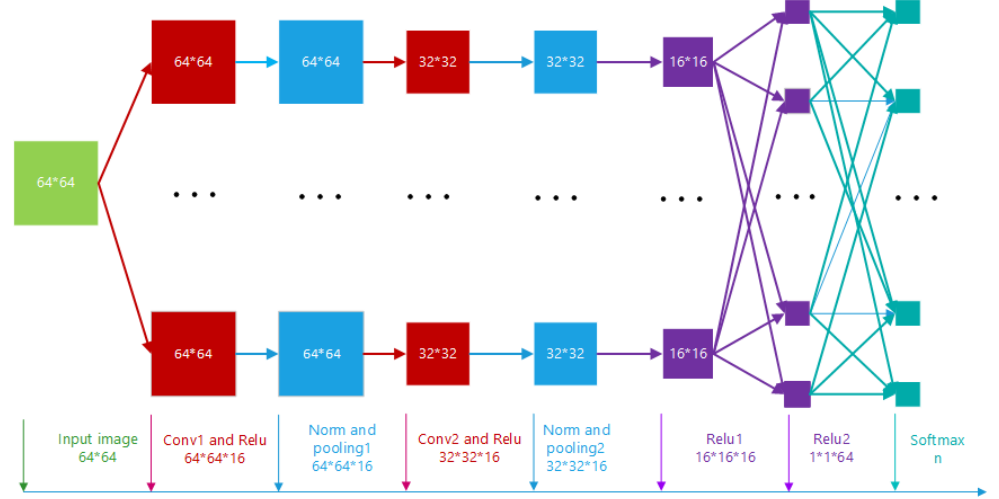
Figure 1. Assembled CNN